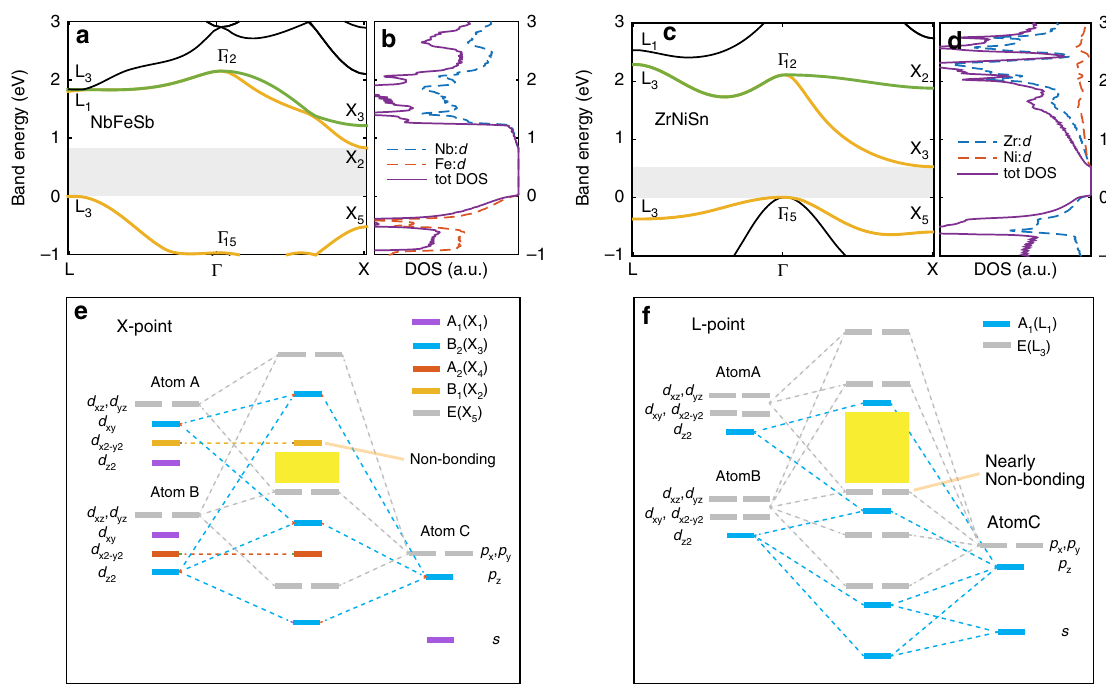
Fig. 2 Crystal orbital analysis. a – d Band structures and corresponding projected density-of-states near conduction and valence band edge for NbFeSb and ZrNiSn. The band states at high-symmetry point (X, Г , and L) are labeled by their corresponding group representations, obtained based on the fi rst principles wavefunctions. Shaded areas in part a , c denote the band gap. e , f Simpli fi ed crystal orbital diagram for a prototypical half-Heusler compound, at X-point and L-point, corresponding to point group symmetry D 2d and C 3v , respectively. The composition is denoted by ABC (B occupies the tetrahedral site, with A, B usually being the transition metals). To avoid complication, we have only employed a minimal basis set where d orbitals at sites A, B, and s , p orbitals at site C are included. Orbitals belonging to different irreducible representations are denoted by different colors. Different p ( d ) orbitals are written apart just to avoid the overlap, while in practice they have the same energy. The yellow regions in part e , f denote the band symmetry — orbitals with representations A 1 do not interact with the valence band edge state of NbFeSb.